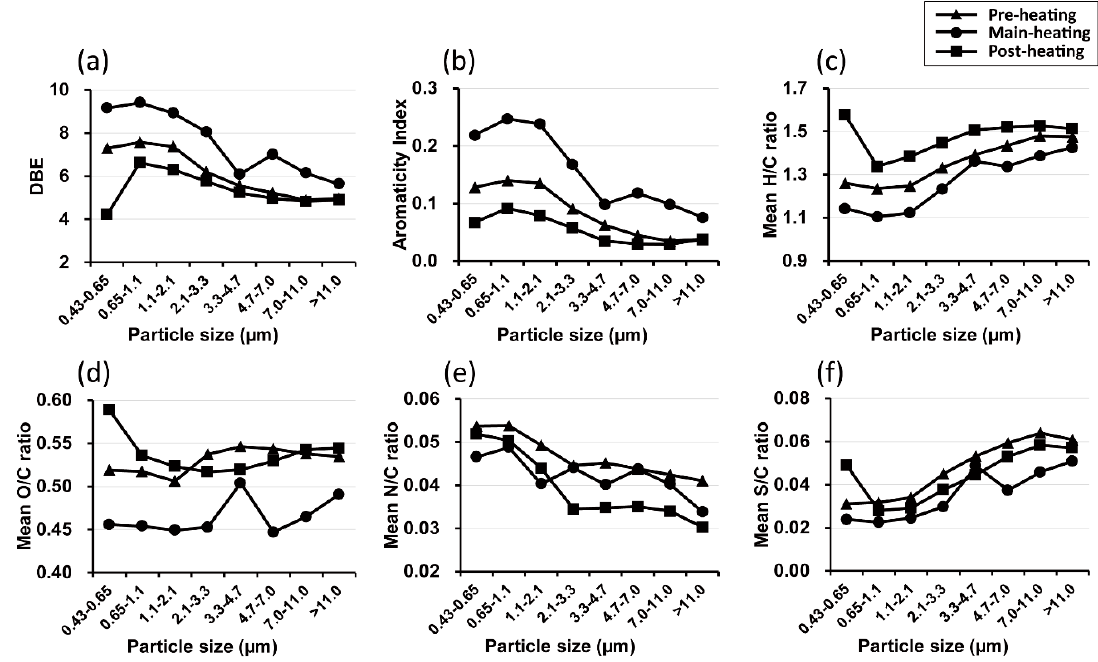
Figure 2. Comparison of the chemical properties of humic-like substances (HULISs) in size-segregated aerosols: ( a ) the double bond equivalent (DBE); ( b ) aromaticity index (AI); and the mean ( c ) hydrogen-to-carbon (H/C), ( d ) oxygen-to-carbon (O/C), ( e ) nitrogen-to-carbon (N/C), and ( f ) sulfur-to-carbon (S/C) ratios.